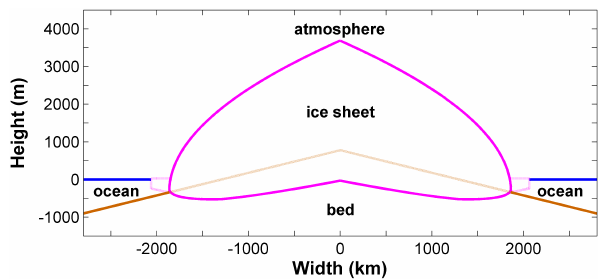
Model and forcing constants